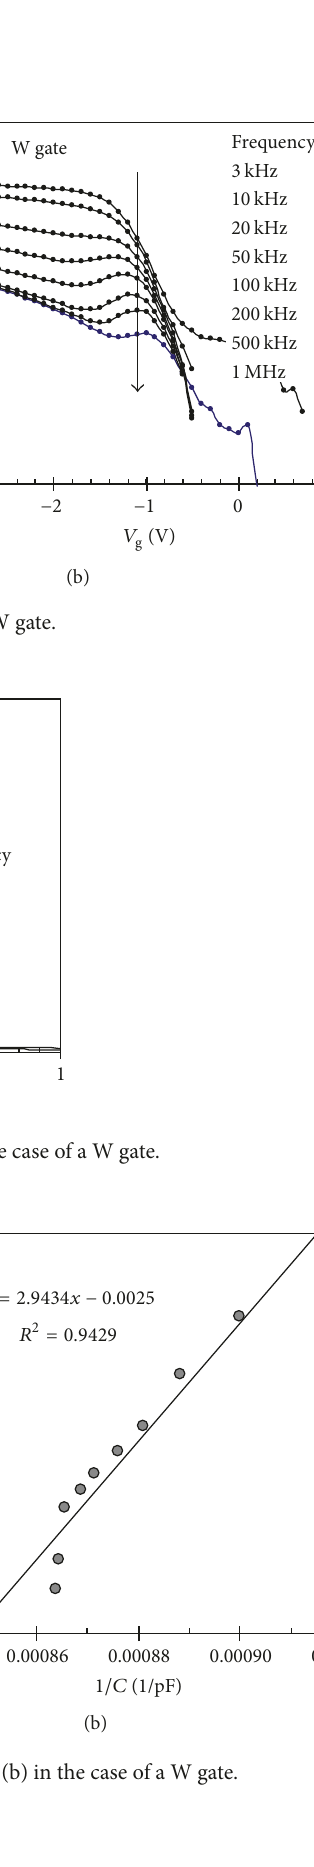
(a) and 𝐶 (b) in the case of a W s p